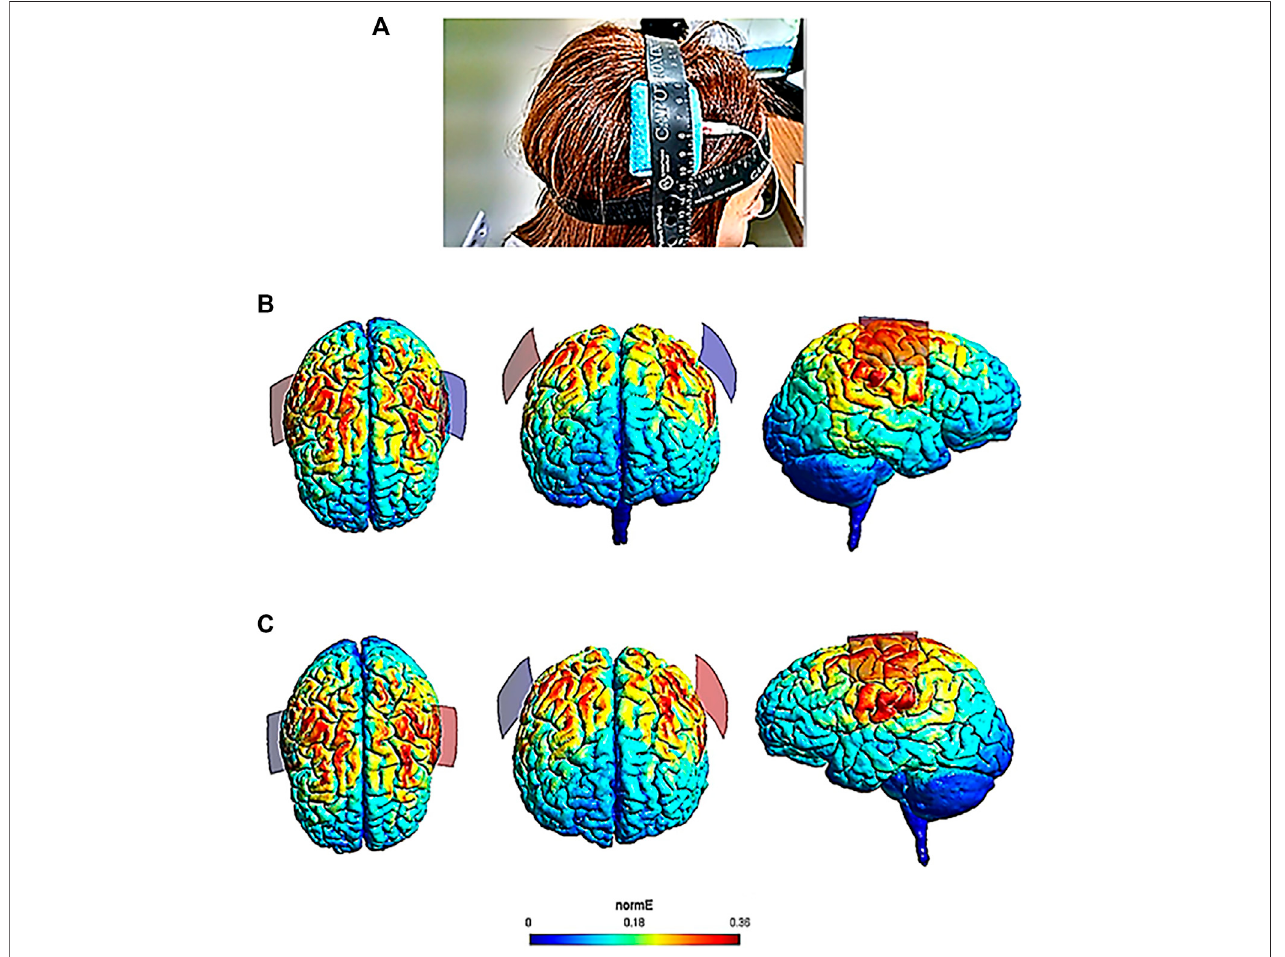
FIGURE 1 | Cerebral electric fi eld intensities calculated by the fi nite element method according to the tDCS electrode con fi guration used in this study. SimNIBS 3.1.2 software was used for modeling of the electric fi eld. Panel (A) shows the electrode con fi guration used in one patient of the study (anode over the right M1 and cathode over the left M1, according to the international 10 – 20 EEG system). Panel (B) (anode over the right hemisphere) includes SimNIBS output brain images of the current fl owfromadorsal,frontalandlateralview.Panel (C) (anodeoverthelefthemisphere)includesSimNIBSoutputbrainimagesfromadorsal,frontalandlateral view. The electric fi eld (normE) intensity (V/m) is shown by the color bar. Brighter colors (higher numbers depicted in the color bar) indicate higher electric fi eld intensity (0.36 V/m). Red and blue electrodes of the SimNIBS output brain images represent the anodal and cathodal electrode position, respectively.